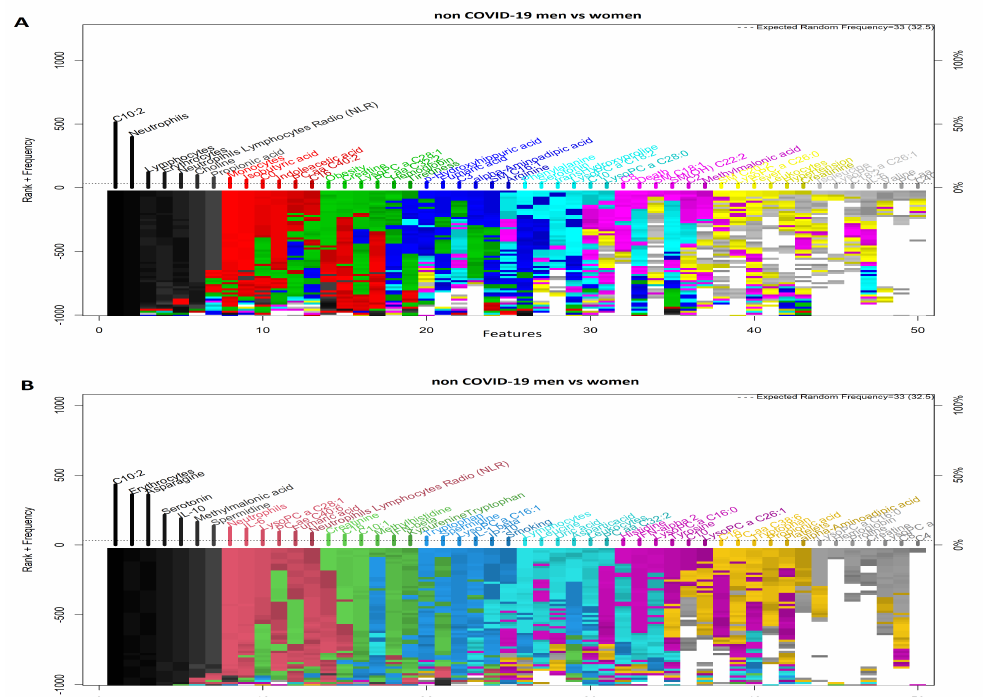
Figure A4. Feature–rank stability in 1000 models, for the classification of non-COVID-19 men and women ( A ) Logistic regression model ( B ) Support Vector Machine model.The ”y positive” axis shows the number of times each feature was included in a given model (the frequency ranking). The ”y negative” axis shows the color coded rank of each feature as each model was generated. The ”x” axis shows the features ordered by rank. Starting color for each feature is assigned accordingly to the feature descending rank (from black down to